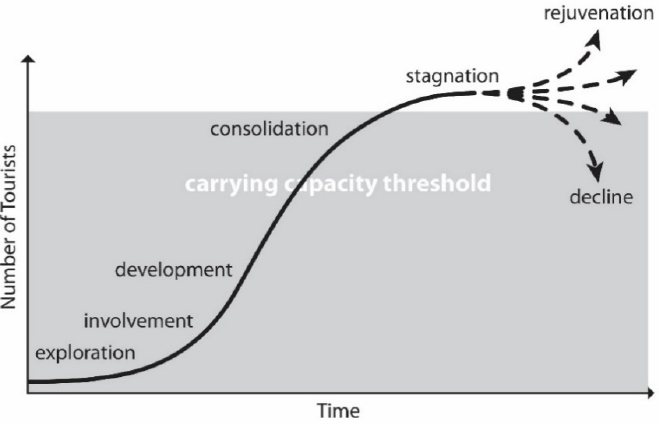
Figure 1. Tourist Area Life Cycle (TALC). Graphic by author, adapted from Butler, 1980.